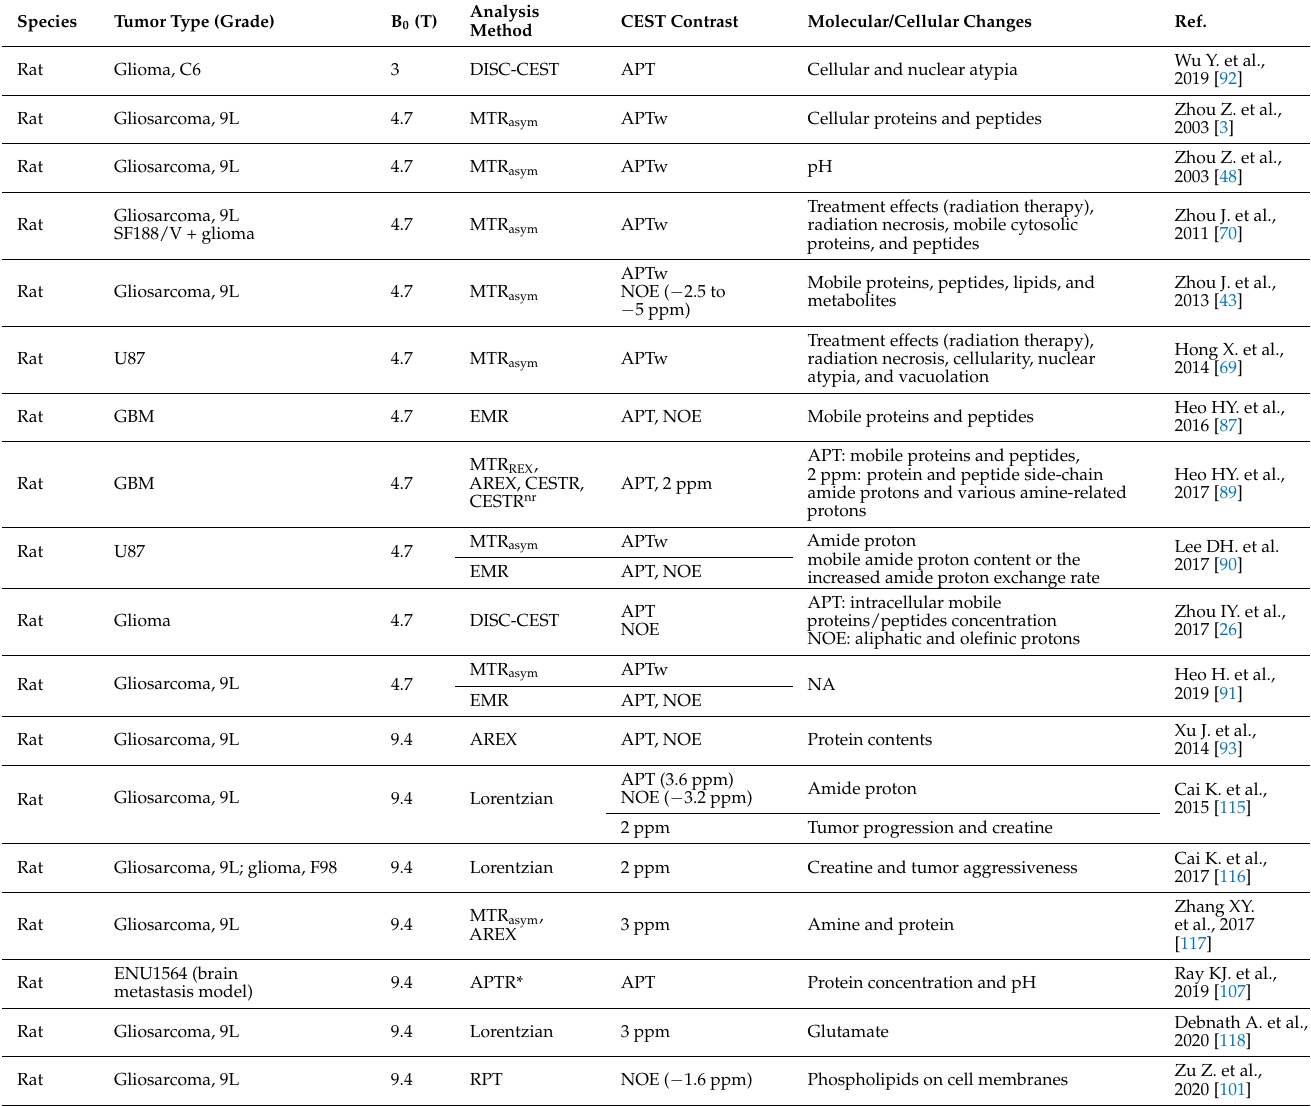
Table 1. CEST MRI of brain tumors using endogenous